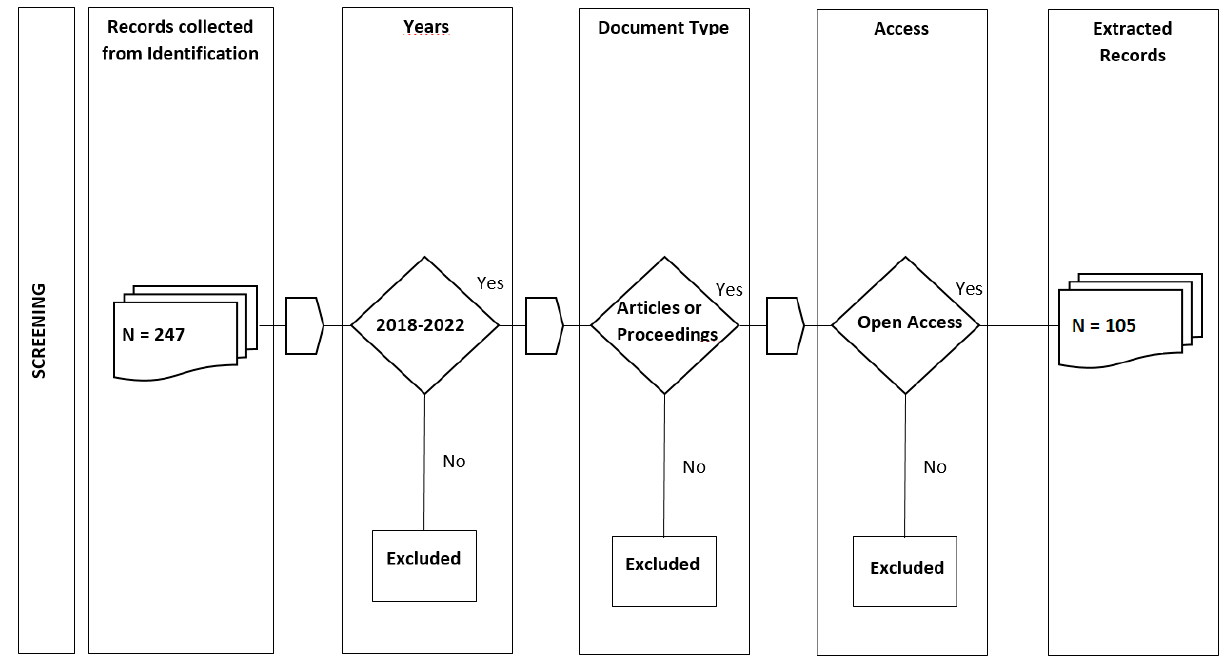
Figure 6. Screening step of the PRISMA framework related to Industry 4.0 in the SME sector. Source: own study, based on the PRISMA methodology.